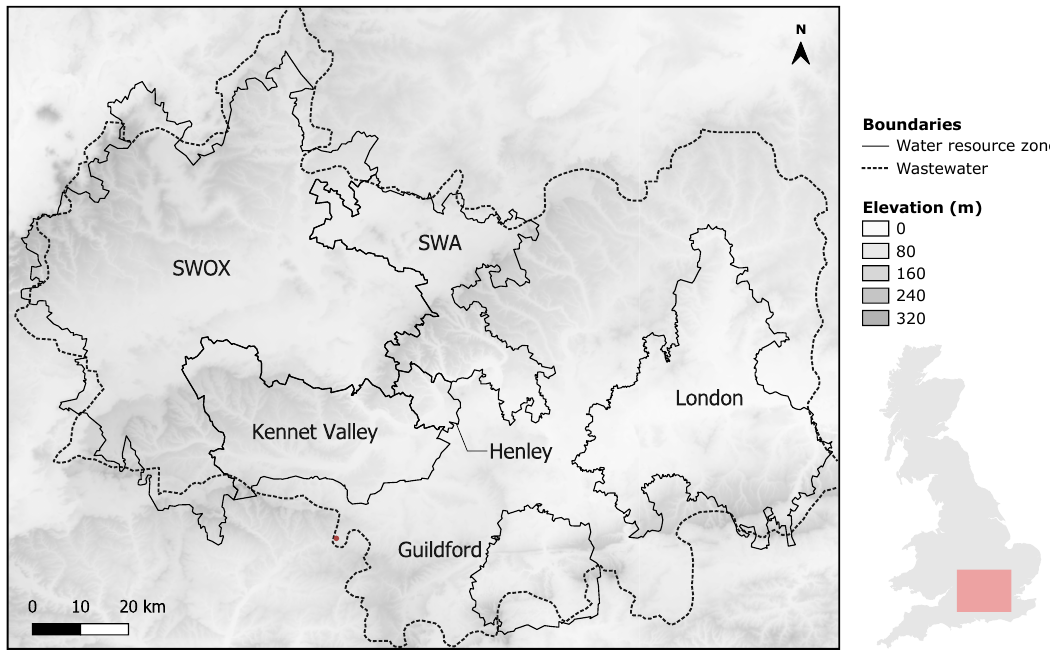
Figure 1. Map of the Thames Water Utilities Ltd. area showing the water supply catchments (black boundaries) and the wastewater resource zone (dotted black line). Elevation is shown in the